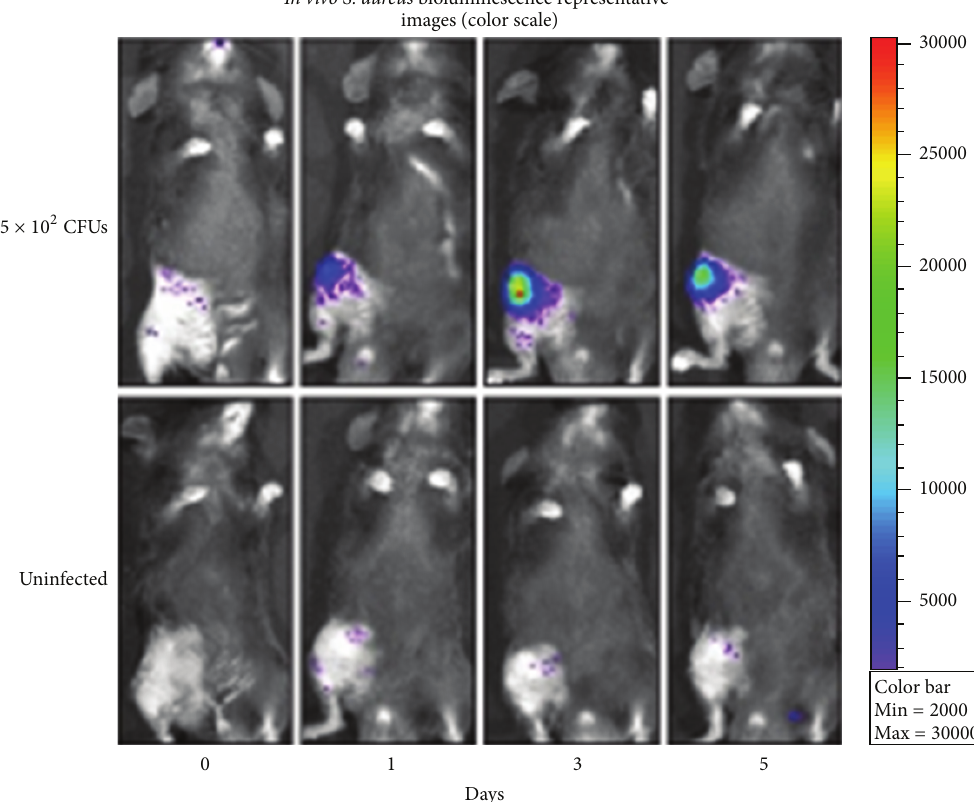
Figure 4: Representative in vivo bioluminescent images